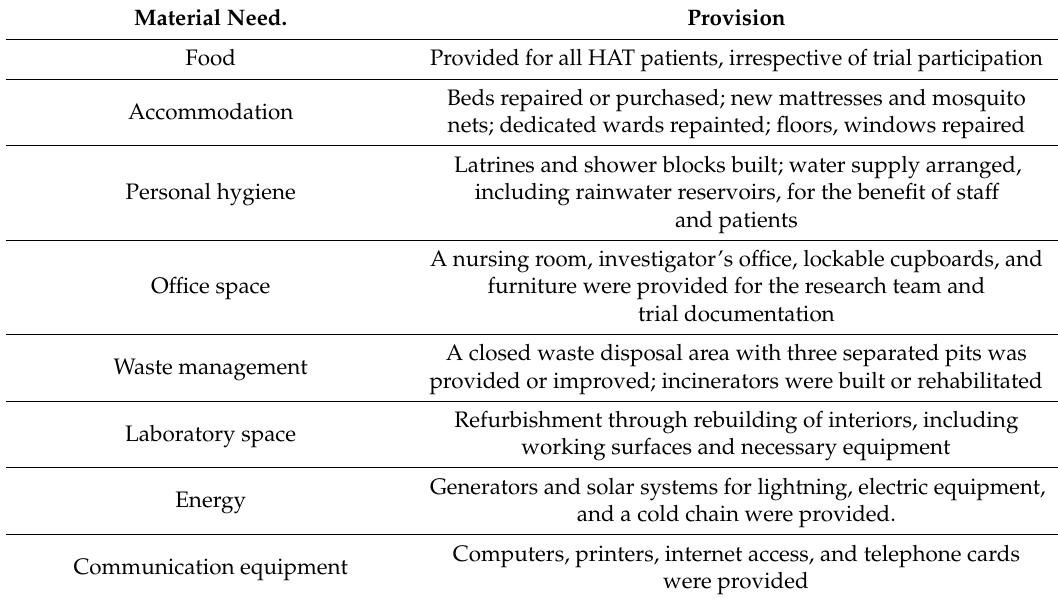
Table 2. List of material needs for the improvement of clinical trial sites and how these needs were